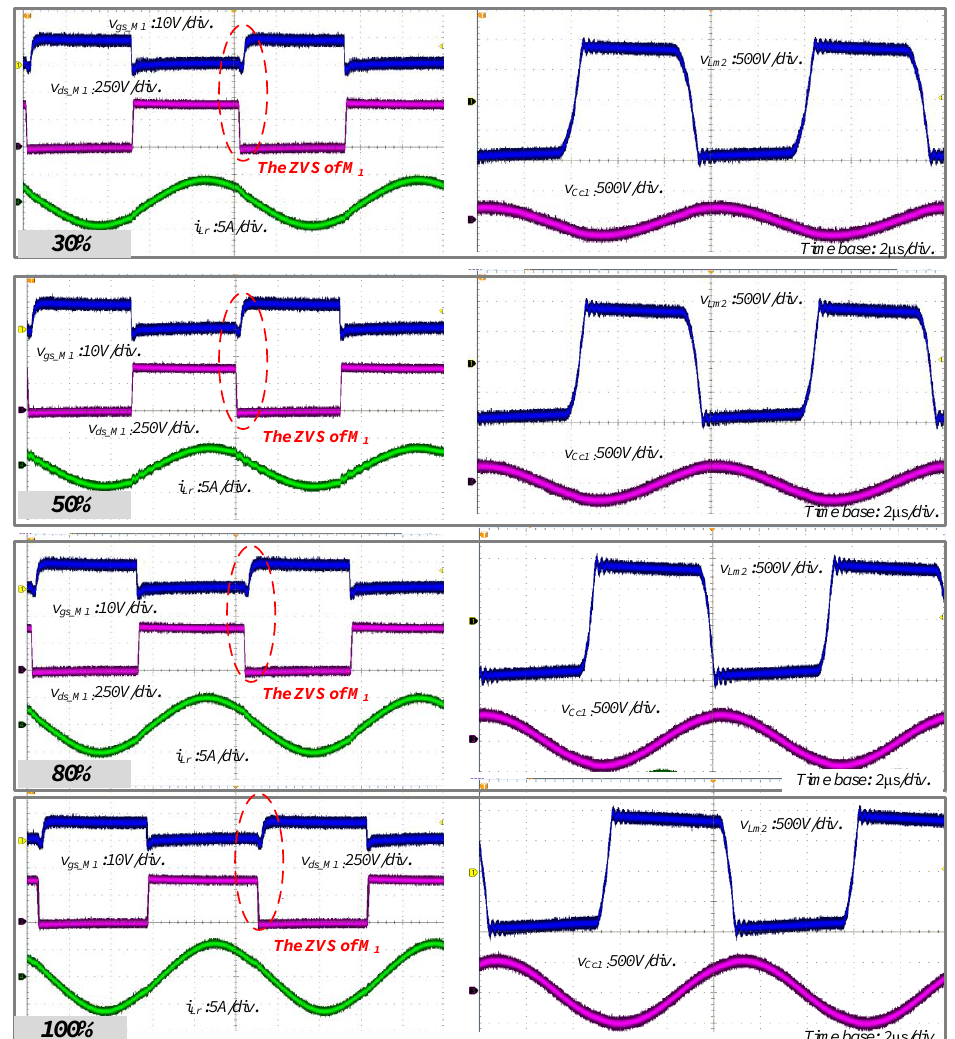
Figure 10. Experimental key waveforms according to load variation: the gate-source voltage of M 1 , the drain-source voltage of M 1 , the resonant inductor current, the voltage across the magnetized inductor of the transformer T 2 , the voltage of the coupling capacitor, the zero voltage switching (ZVS) operation of M 1 . Electronics 2020 , 9 , x FOR PEER REVIEW